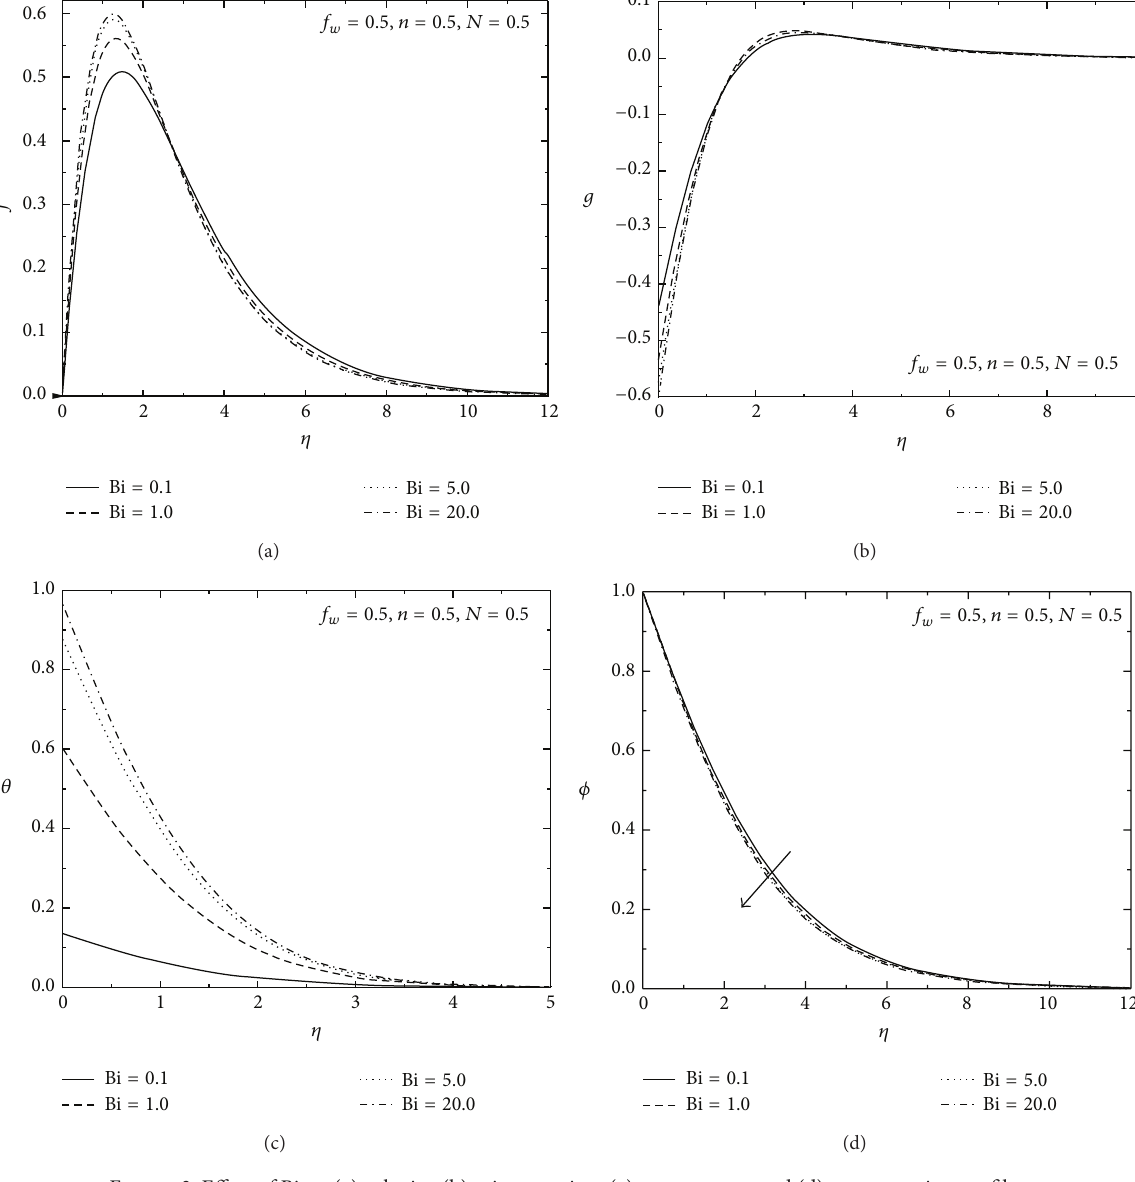
of antisymmetric part of the stress on the boundary that corresponds to a weak concentration of microelements. This is because an increment in the value of 𝑁 implies a higher vortex viscosity of fluid which promotes the microrotation of micropolar fluids. It is seen from Figures 2(c) and 2(d) that thermal and concentration boundary layers of the fluid increase with increase in coupling number 𝑁 . Hence, temperature and concentration in case of micropolar fluids are more than those of the viscous fluid